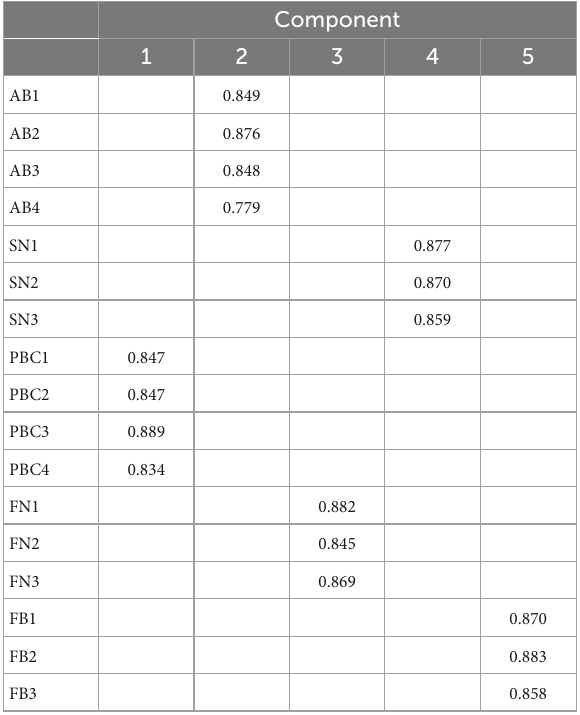
TABLE 6 Extraction factor.